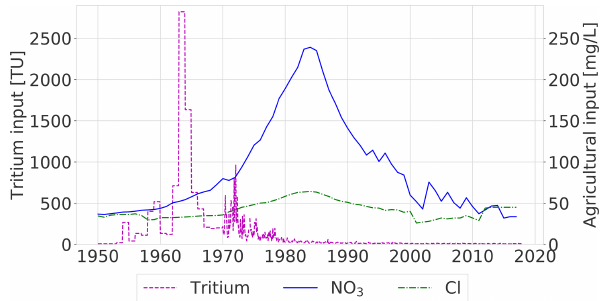
Figure 3. Input time series for tritium (left axis) and the estimated concentrations of nitrate and chloride under farmland (right